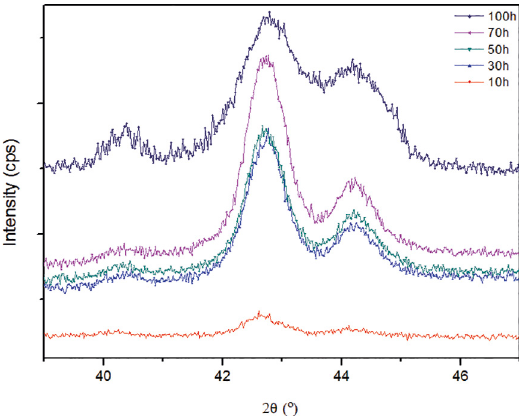
Figure 12. XRD spectra of aluminium bronze peak widening after